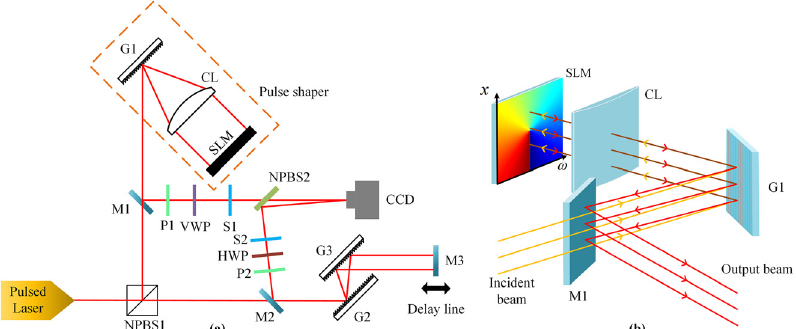
Figure 1: Schematic drawing of the experimental setup. (a) Experimental setup for generating and characterizing vectorial spatiotemporal vortices. (b) The 3D perspective of the pulse shaper. M: mirror; G: grating; CL: cylindrical lens; P: polarizer; NPBS: non-polarizing beam splitter; S: shutter; VWP: vortex wave plate and HWP: half-wave plate.